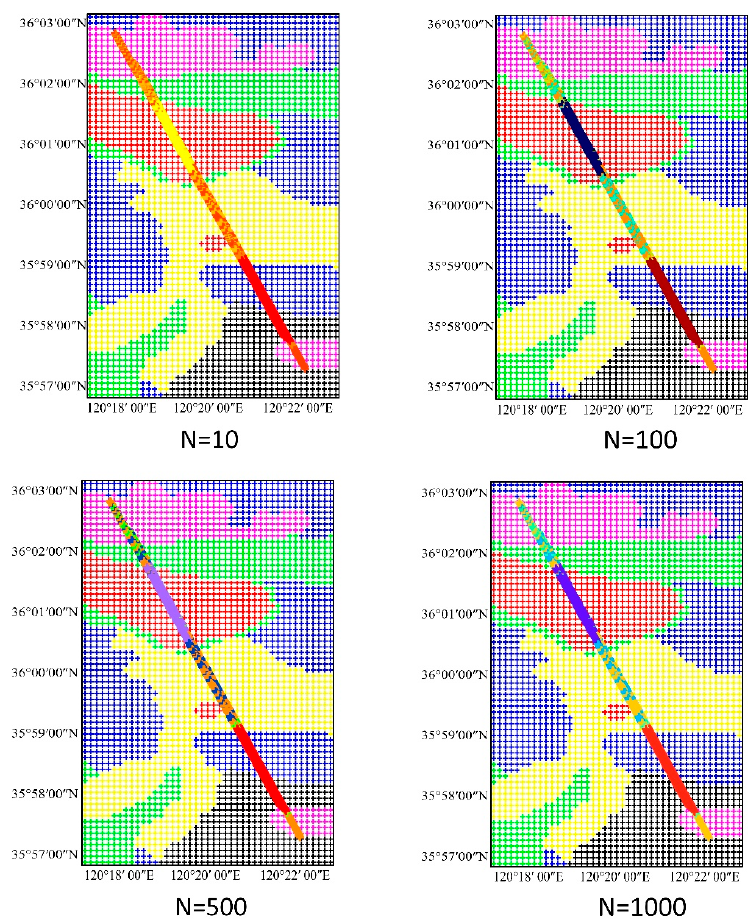
Figure 8. SOM network classification under different training steps.